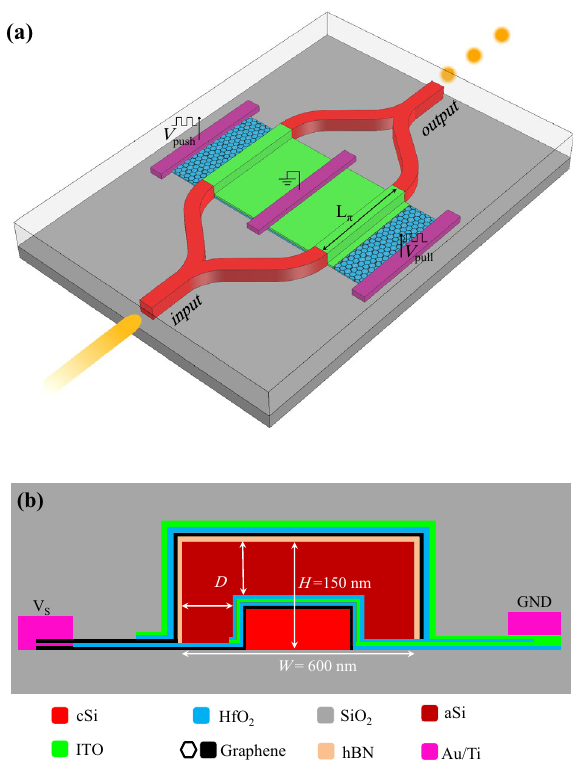
Figure 1. ( a ) Perspective view of the MZM in push-pull configuration. ( b ) Cross section view of the proposed ITO/graphene-based waveguide.